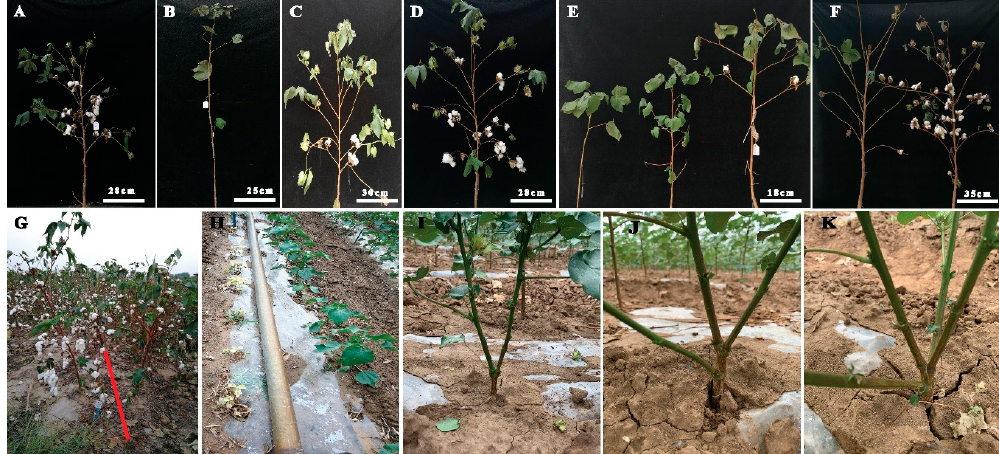
Figure 3. Phenotypic analysis of plant architecture in EMS-induced mutants. ( A ) Wild type plant architecture, ( B ) mutant phenotype without fruiting branch, ( C ) medium height with spreading